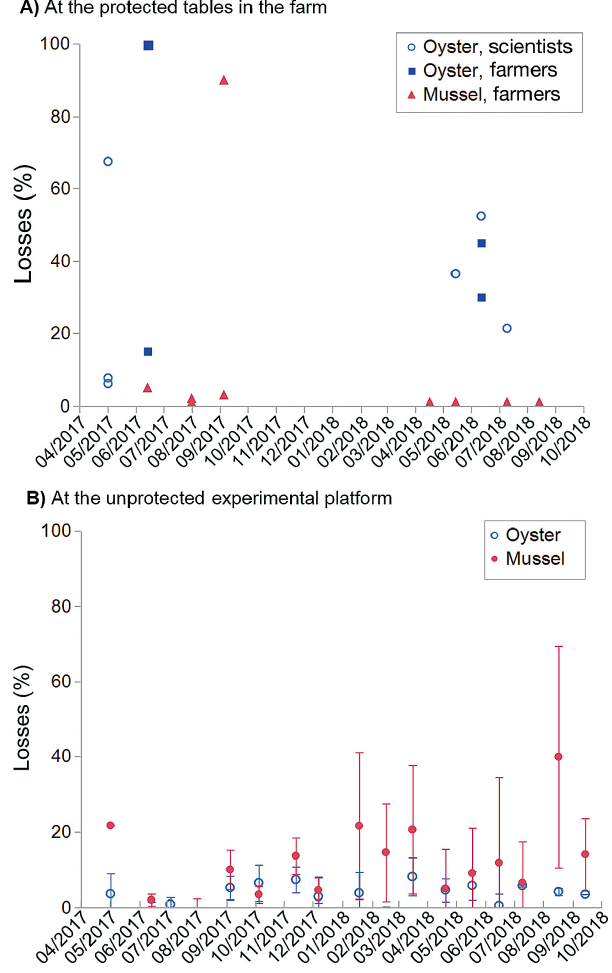
Fig. 7. (A) Estimated mussel and oyster losses recorded by farmers and scientists at the protected tables in the bivalve farm and (B) mean (±SD) bivalve losses associated with signs of predation (broken shells or detached oysters) for mussel and oyster ropes suspended at the unprotected experimental platform from May 2017 to September 2018. When no predation was detected, no data was reported in the